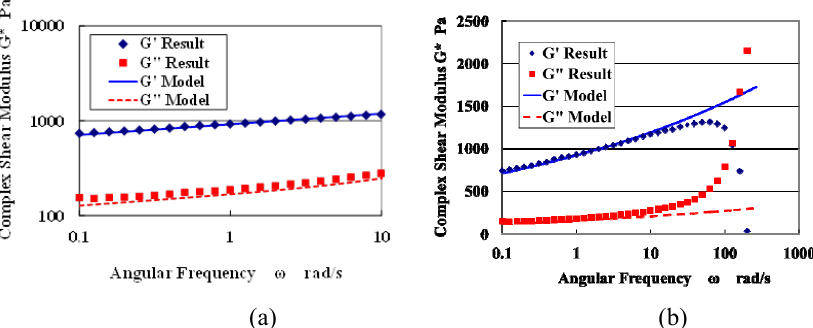
Fig. 2 Mechanical impedance of the liver. G* is the complex shear modulus; G’ is the storage elastic modulus, and G” is the loss elastic modulus. The red and blue plots are the experimental results, and the red and blue lines are the responses of our model for (a) over the range of 0.1–10 rad/sec (b) over 10 rad/sec for the vibration of creep test (ref: Fig.3 (b)).